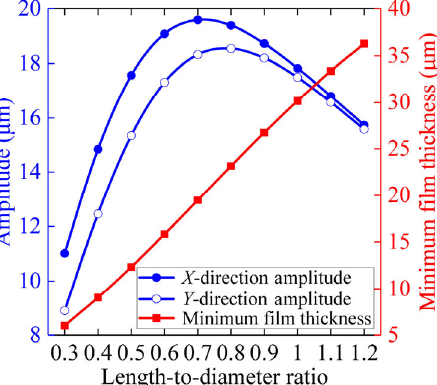
Fig. 10 Journal amplitudes and minimum film thicknesses of a TPJB with static loads as a function of length-to-diameter ratios.